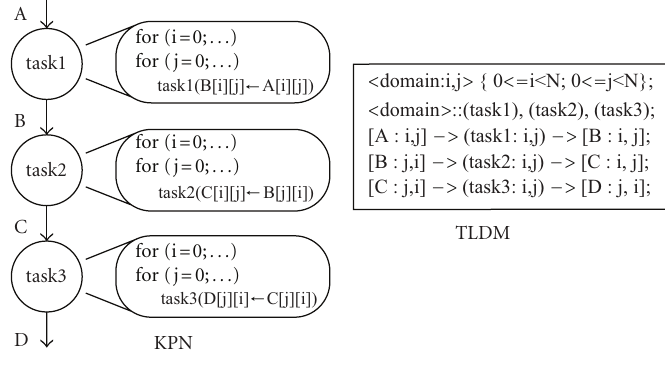
Figure 9: Support for task